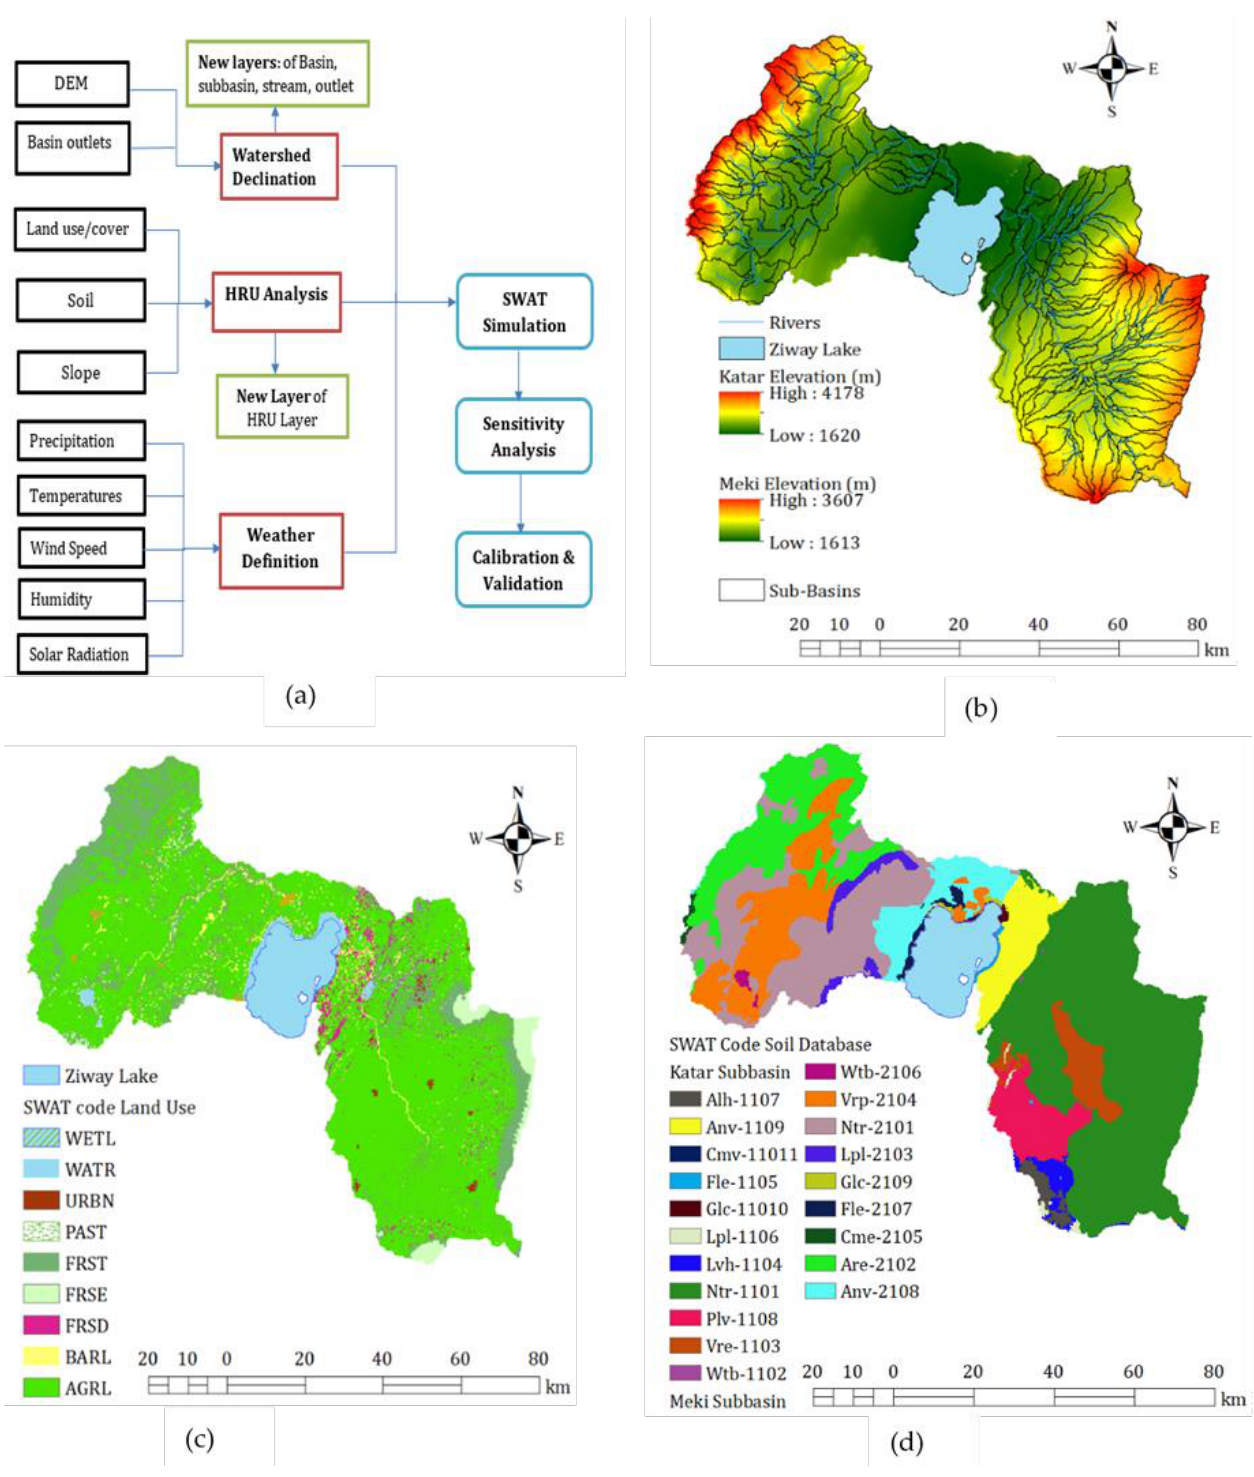
Figure 2. Schematic workflow ( a ), digital elevation model ( b ), land use land cover ( c ), and soil type ( d ).